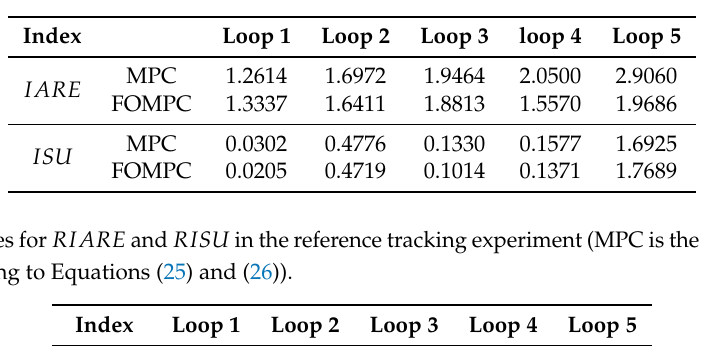
Table 5. Indexes for IARE and ISU in the reference tracking experiment.